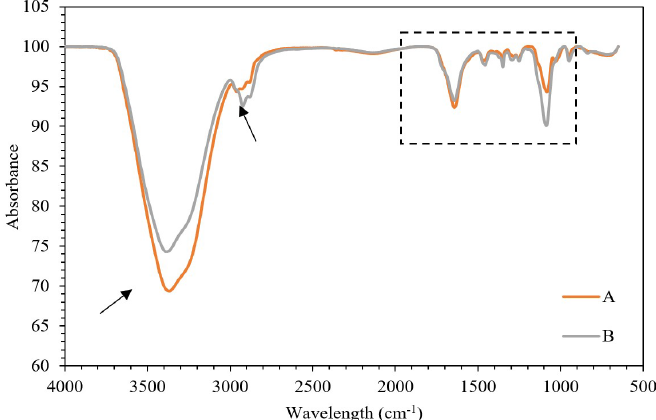
Figure 2. FTIR spectra of surfactants SA and SB.